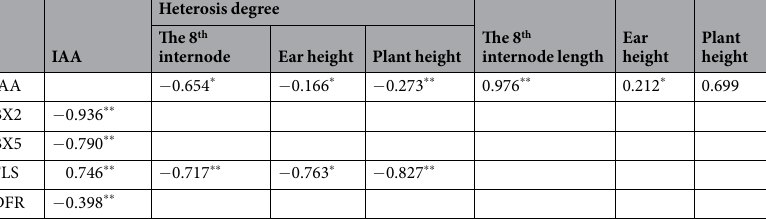
Heterosis degree